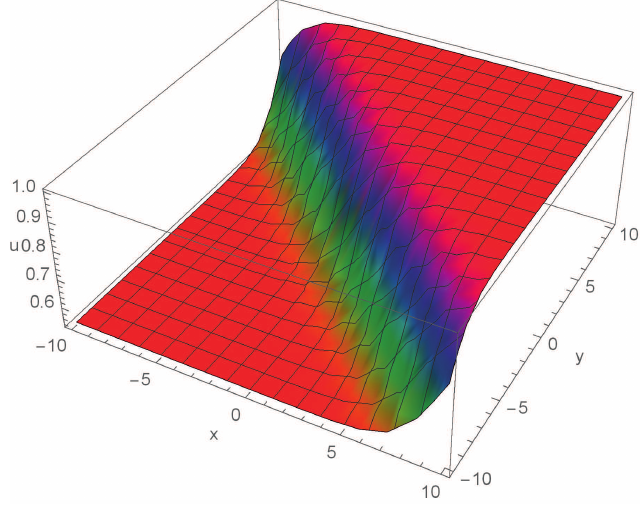
Fig. 3 The surface plot of the PIA solution u 4 ( x , y , t ) for ℜ = 100 and t = 0 . 1 when α = 0 . 85